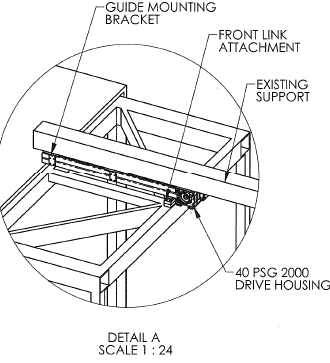
Figure 2: Schematic diagram of the retraction system proposed for the glass boxes.